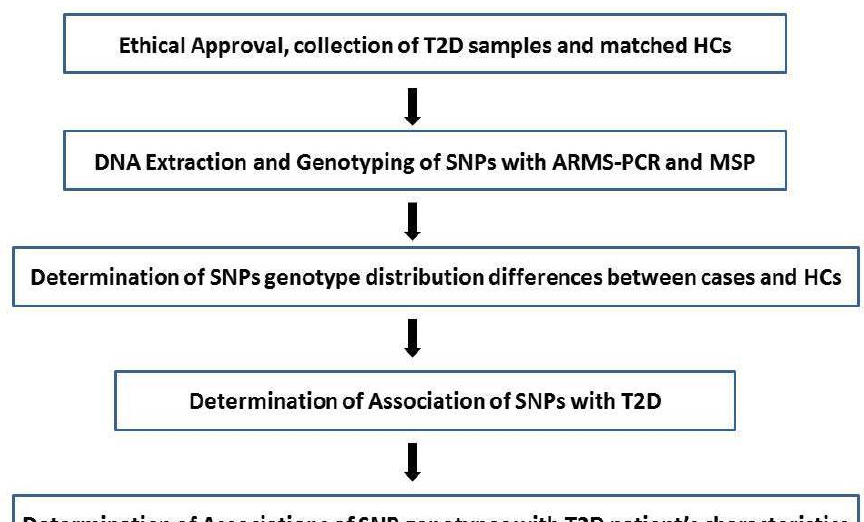
Figure 1. Summary of the study explaining the procedure from sample collection until statistical analyses. Abbreviations. HCs: healthy controls. ARMS-PCR: amplification mutation system PCR. MSP: mutation specific PCR.